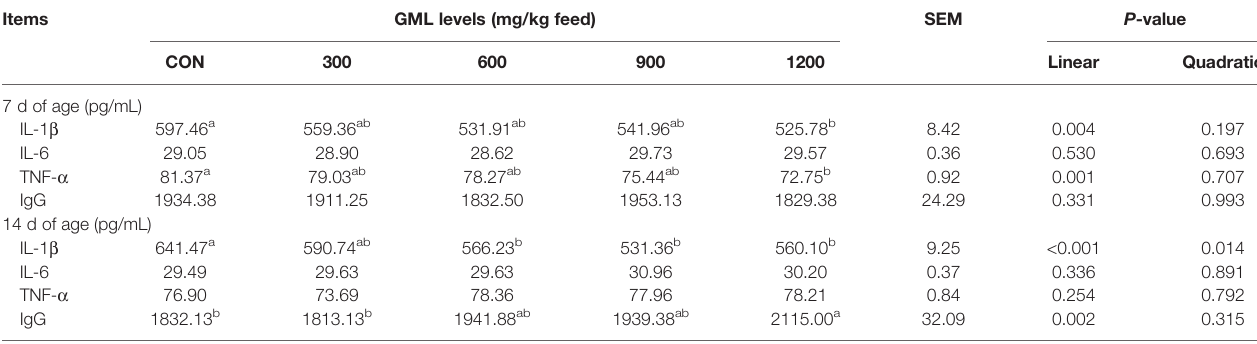
TABLE 4 | Effects of dietary treatment on immune indicators in the sera of 7- and 14-day-old broilers.